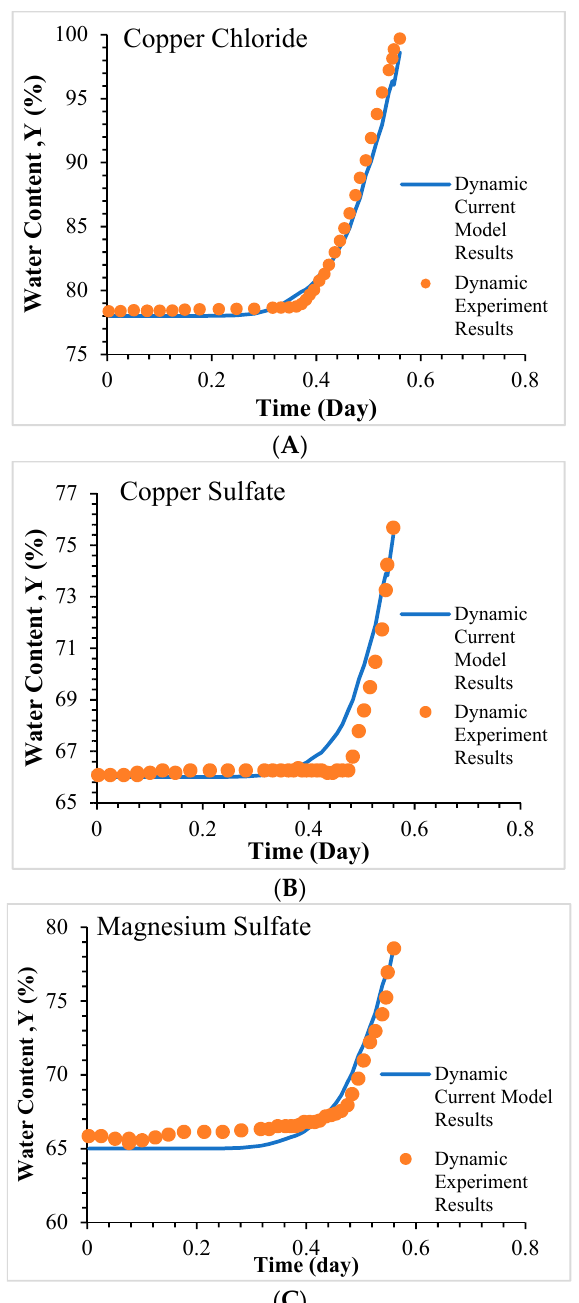
Figure 4. Comparison between the computed water contents against the experimental data using the dynamic RHs of ( A ) copper chloride, ( B ) copper sulfate, and ( C ) magnesium [18].